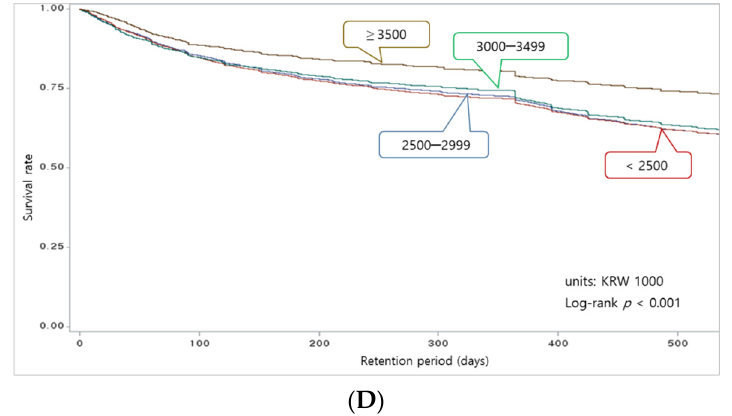
Figure 1. Survival curves by hospitals’ characteristics ( A ) Comparison of the likelihood of remaining at work by hospital location. ( B ) Comparison of the likelihood of remaining at work by hospital ownership. ( C ) Comparison of the likelihood of remaining at work by bed-to-nurse ratio. ( D ) Comparison of the likelihood of remaining at work by standardized monthly income. KRW, Korean Won. Male nurses had a lower likelihood of remaining at work than females ( p < 0.001), and the rate decreased as nurses’ ages increased ( p < 0.001) (Figure 2). All survival curves according to the characteristics of hospitals and nurses showed a significant drop between 300 and 400 days of employment.